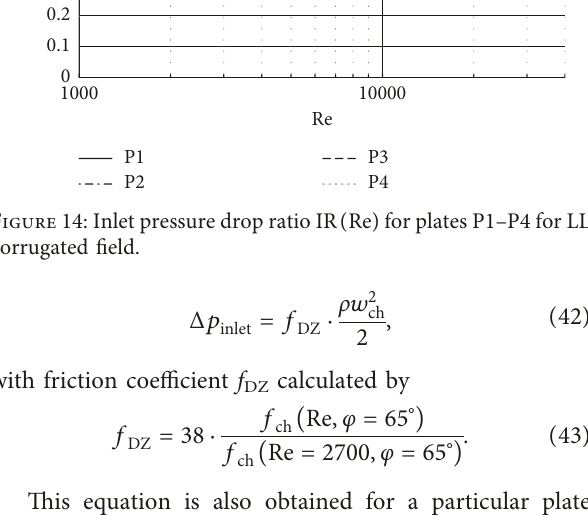
Re for plates P1–P4 for ( )